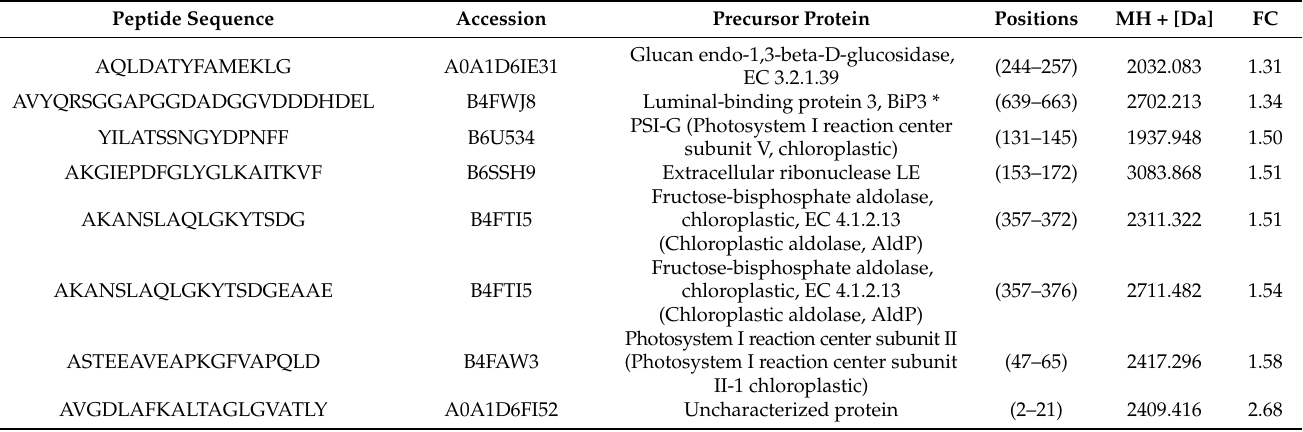
Figure 7. Gene ontology (GO) classification and Kyoto Encyclopedia of Genes and Genomes (KEGG) enrichment of differentially expressed peptides (DEPs) in maize. ( a ) The results are summarized in three main categories: biological process; cellular component; and molecular function. The x -axis indicates the number and percent of genes in a category. The y -axis indicates the most enriched GO terms in three main categories. Max level indicates maximal annotated level of this term in the GO graph. ( b ) Distribution of enriched KEGG pathway analysis of the 147 precursor proteins of com- mon DEPs. The x -axis indicates rich factor and the y -axis indicates pathway. 3. Discussion In natural ecosystems, plants fall victims to biotic and abiotic stresses, which affect their growth, development, yield, and quality [39 – 42]. As a result, plants have evolved complex mechanisms to perceive external signals and to respond promptly and ade- quately to potential phytopathogens [43 – 46]. Peptidomics has been extensively applied in the discovery and functional research of neuropeptides and hormones [29,30]. However, there are only a few descriptions of plant biotic stress responses from the perspective of plant peptides and plant peptidomics [47]. In this exemplary study, we searched for and identified many peptide changes in maize peptidome following B. maydis infection. Sub- sequently, we summarized the adaptive or defensive peptides produced by maize in re- sponse to SCLB stress. The knowledge gathered from the characteristics of the DEPs in infected maize helps us further understand the pathophysiology of SCLB development